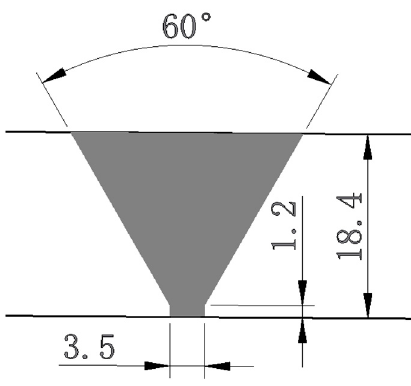
Figure 4. Weld joint (dimensions in mm).